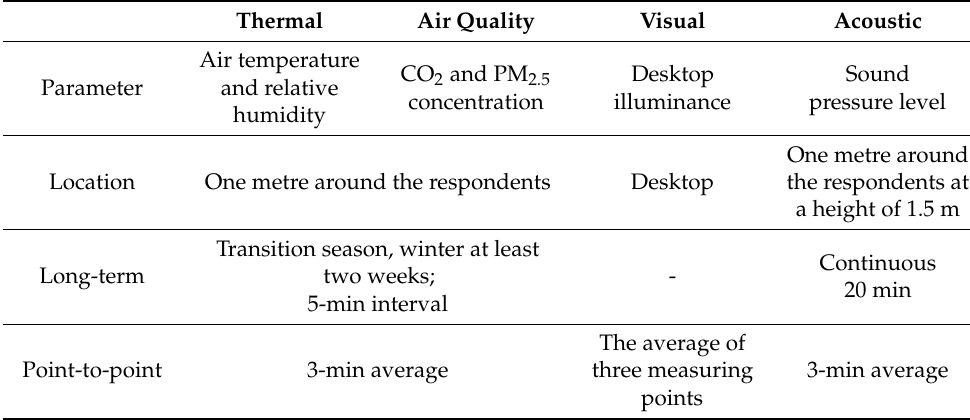
Table 2. Long-term and point-to-point indoor environment measurement